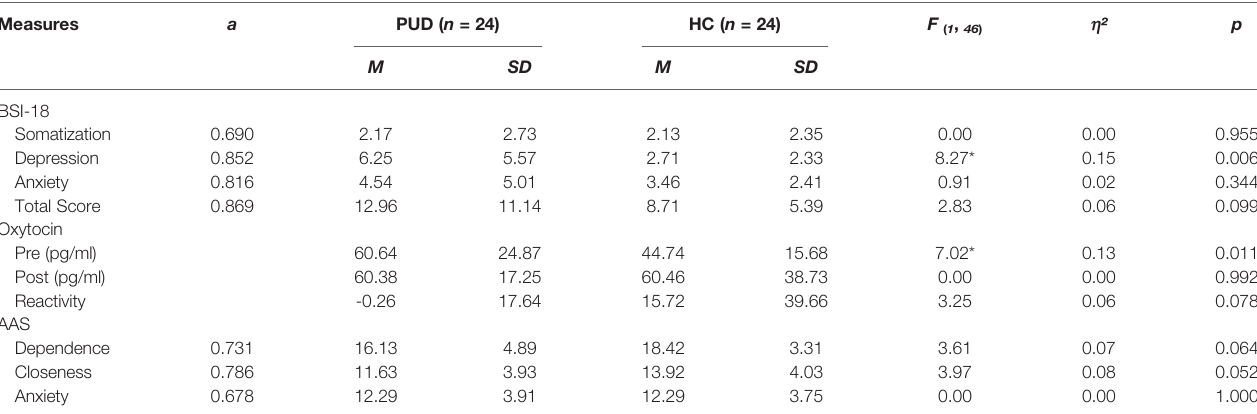
TABLE 2 | Group differences (ANOVA) in behavioral and biological